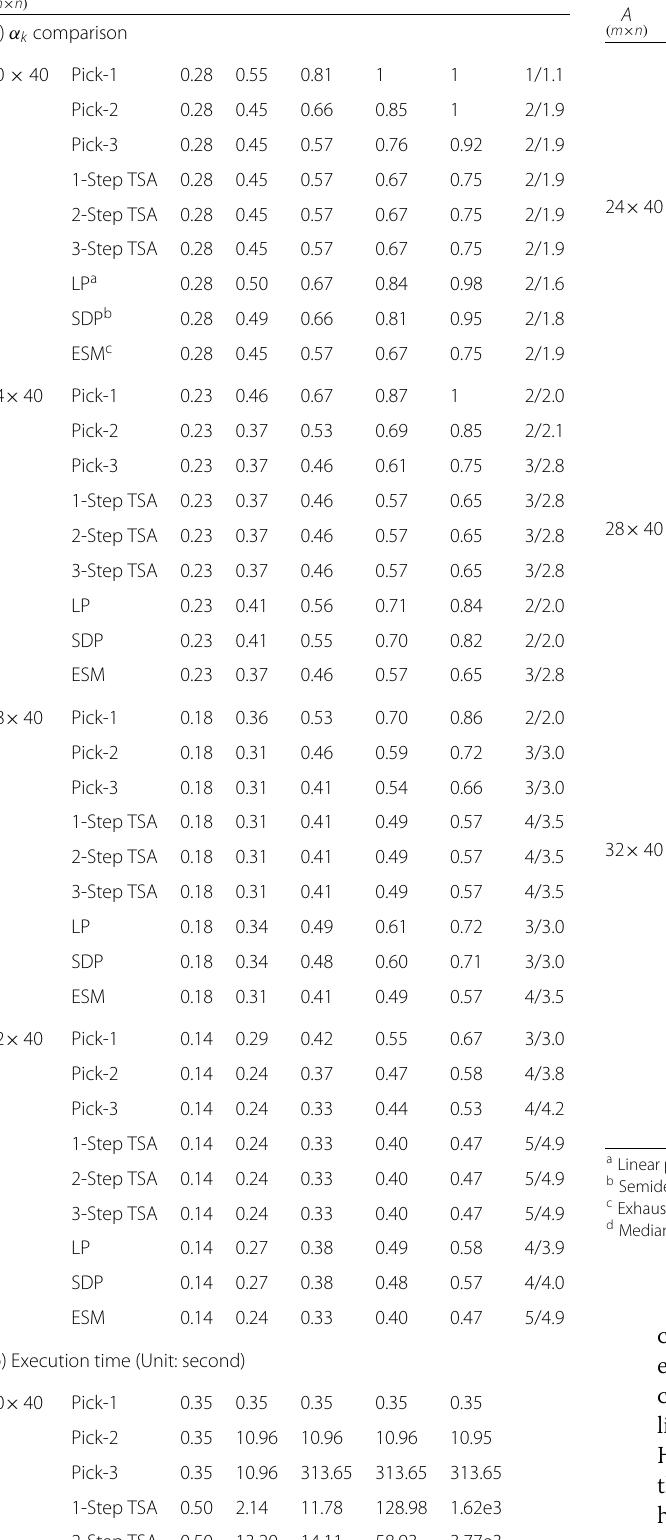
Table 7 α k comparison and execution time - Gaussian Matrix A ( m × n )